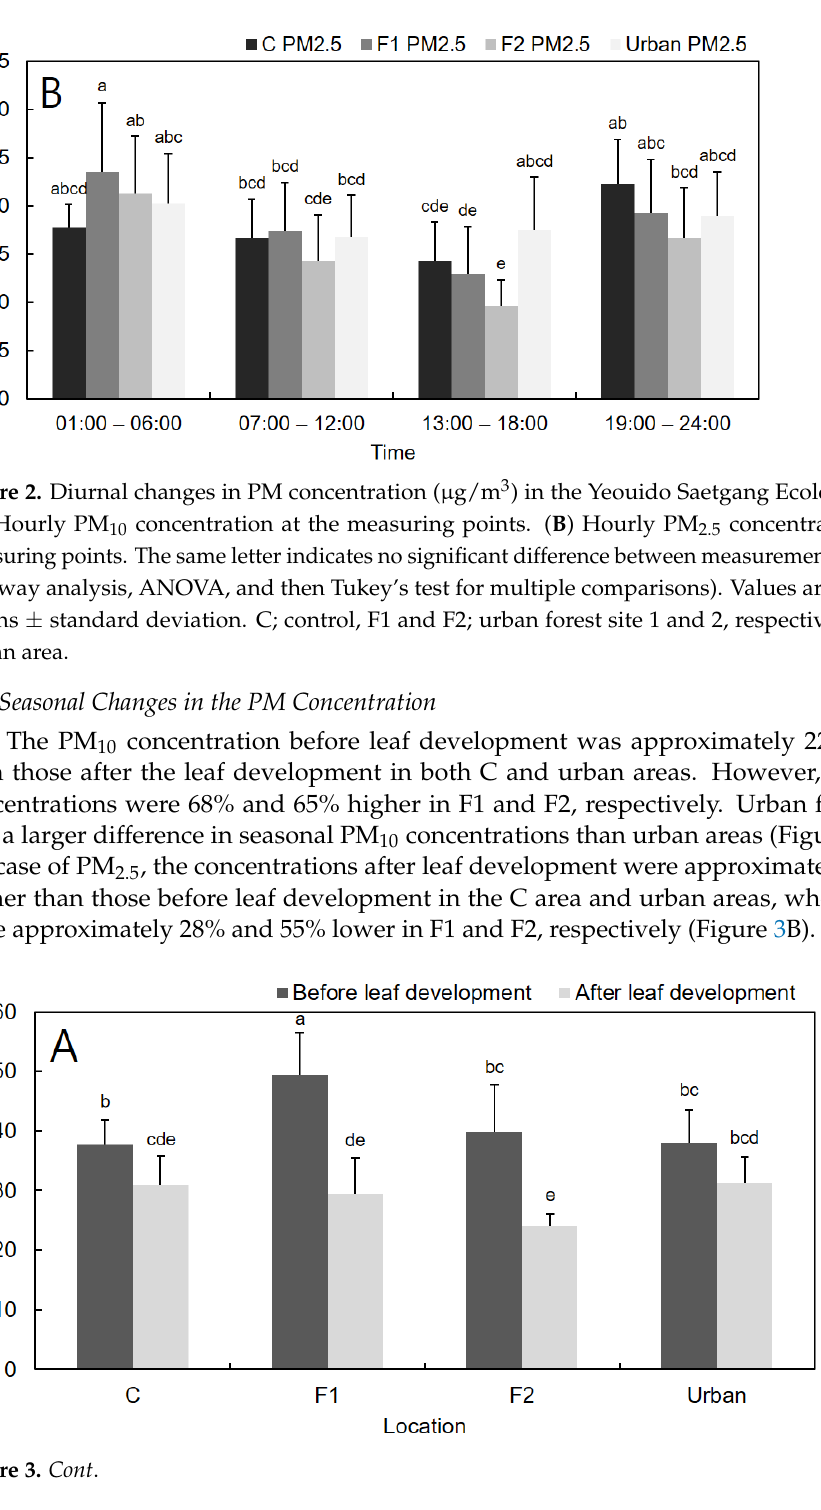
Figure 3. Seasonal changes in PM concentration (µg/m 3 ) in Yeouido Saetgang Ecological Park. ( A ) PM 10 concentration before and after leaf development at the measuring points. ( B ) PM 2.5 concentration before and after leaf development at the measuring points. The same letter indicates no significant difference between measurements ( p < 0.05, one-way ANOVA and then Tukey’s test for multiple comparisons). Values are shown as means ± standard deviation. C; control, F1 and F2; urban forest site 1 and 2, respectively, Urban; Urban area. Table 2. Meteorological conditions at two willow forests in Yeouido Saetgang Ecological Park during the study period. Region